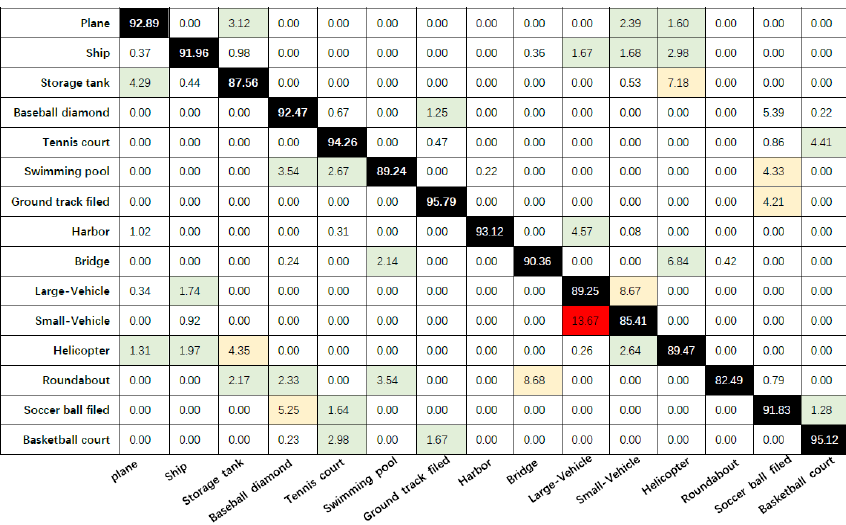
Figure 9. Confusion matrix for YOLOv3 with auxiliary network.